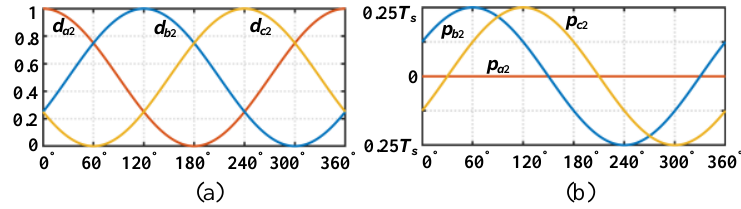
Figure 9. ( a ) The duty cycle in one period. ( b ) The phase shift in one